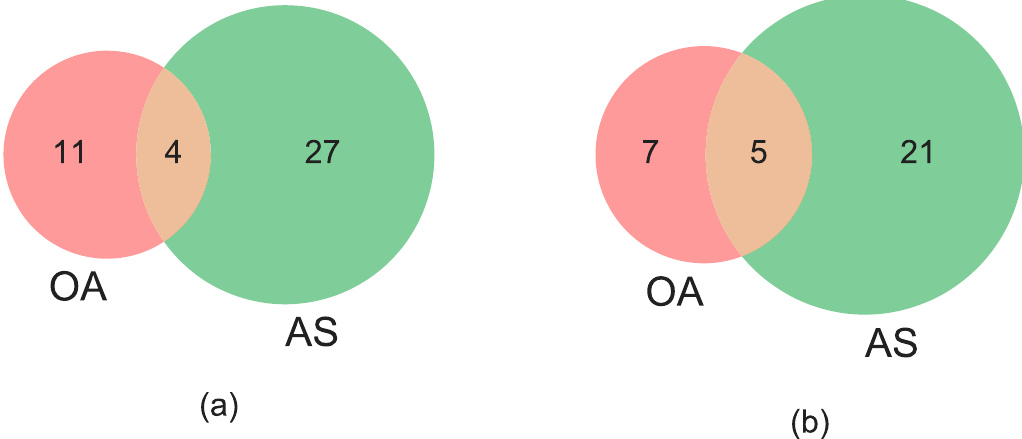
Figure 2. Venn diagrams showing degree of overlap between tag SNPs developed for Open Array (OA) and amplicon sequencing (AS) inversion genotyping of 3Ra (panel ( a )) and 3Rb (panel ( b )).